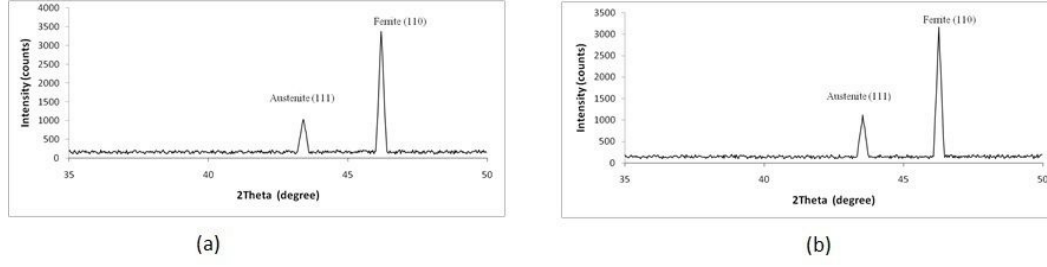
Figure 8. XRD graphs for samples austenitized at 950ºC and austempered at 420ºC with (a) 0.268 wt% Mn, (b) 1.01 wt% Table 2. Amount of retained austenite at different conditions.